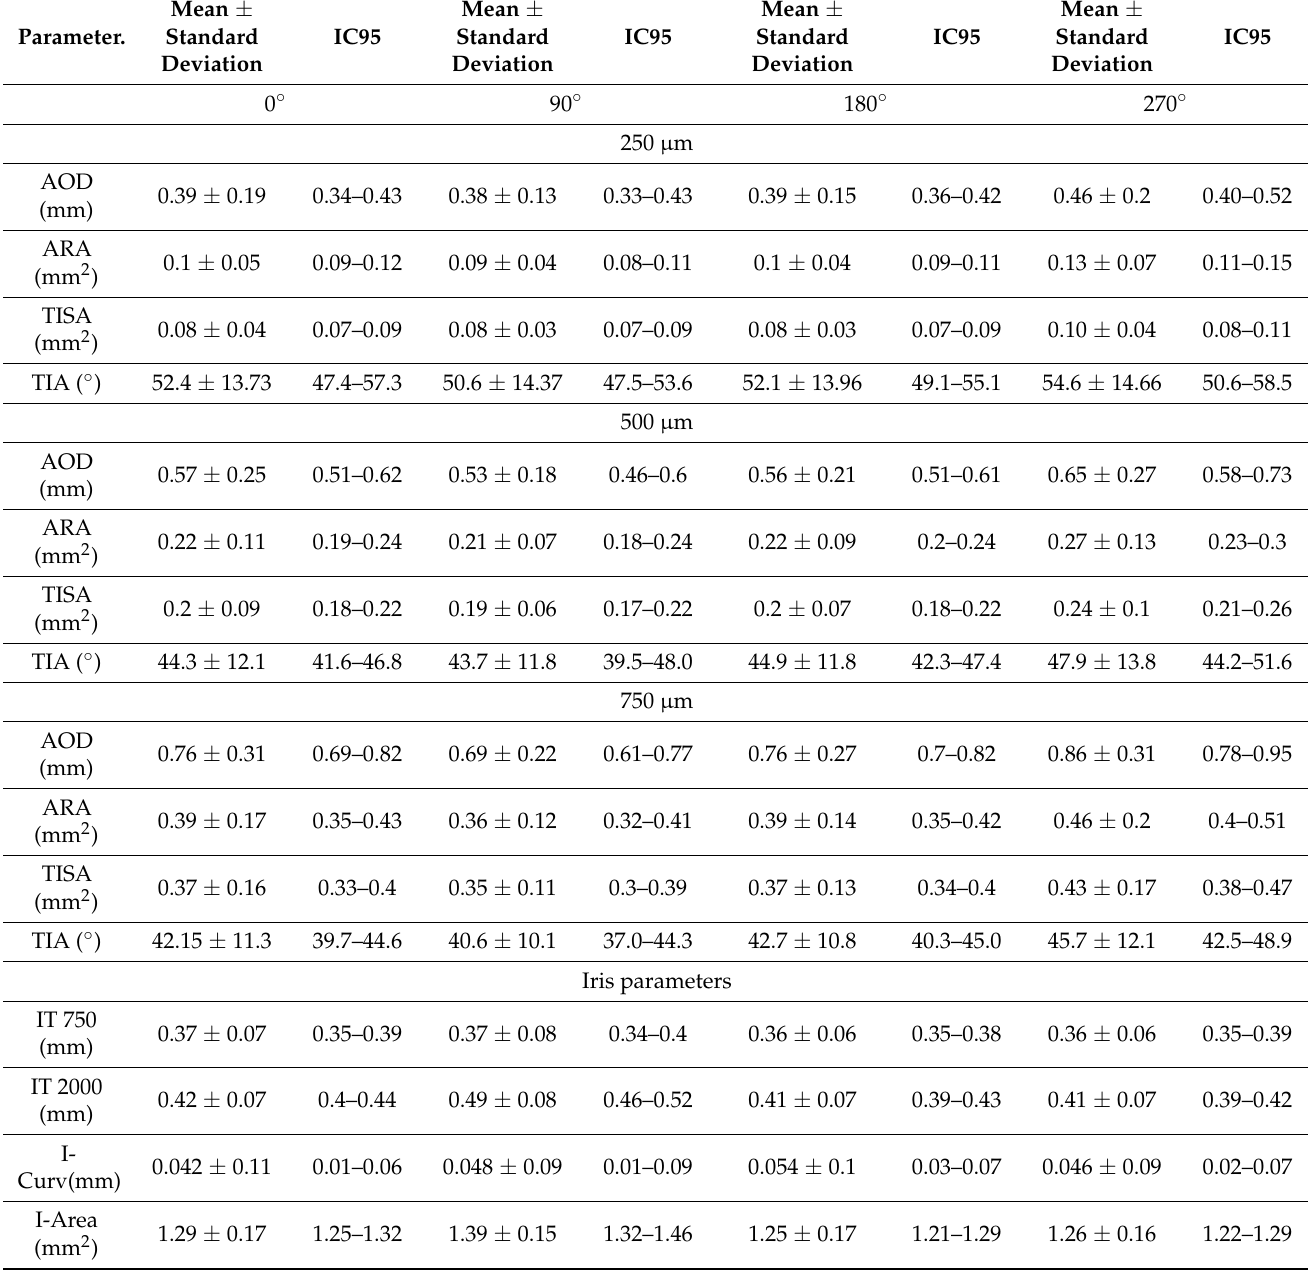
Table 3. Comparison of the parameters of the filtration angle and the